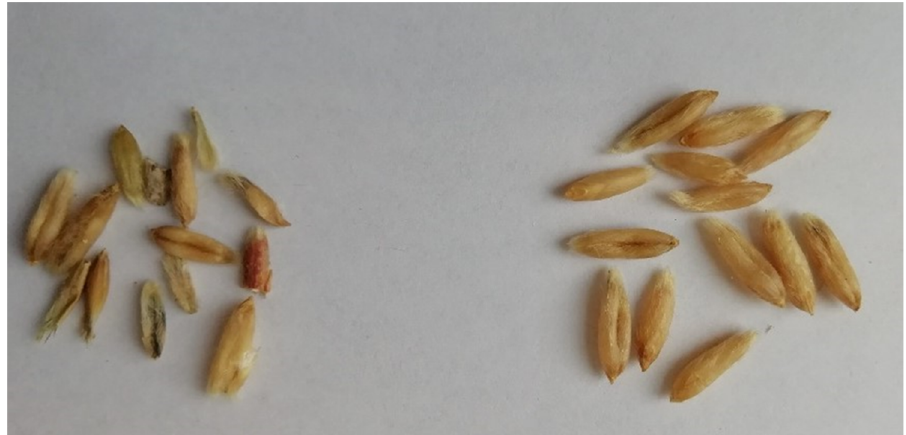
Figure 2. Oat kernels (without chaff) from panicle after inoculation with F. equiseti ( left ) and kernels from control panicles (without inoculation) ( right ).